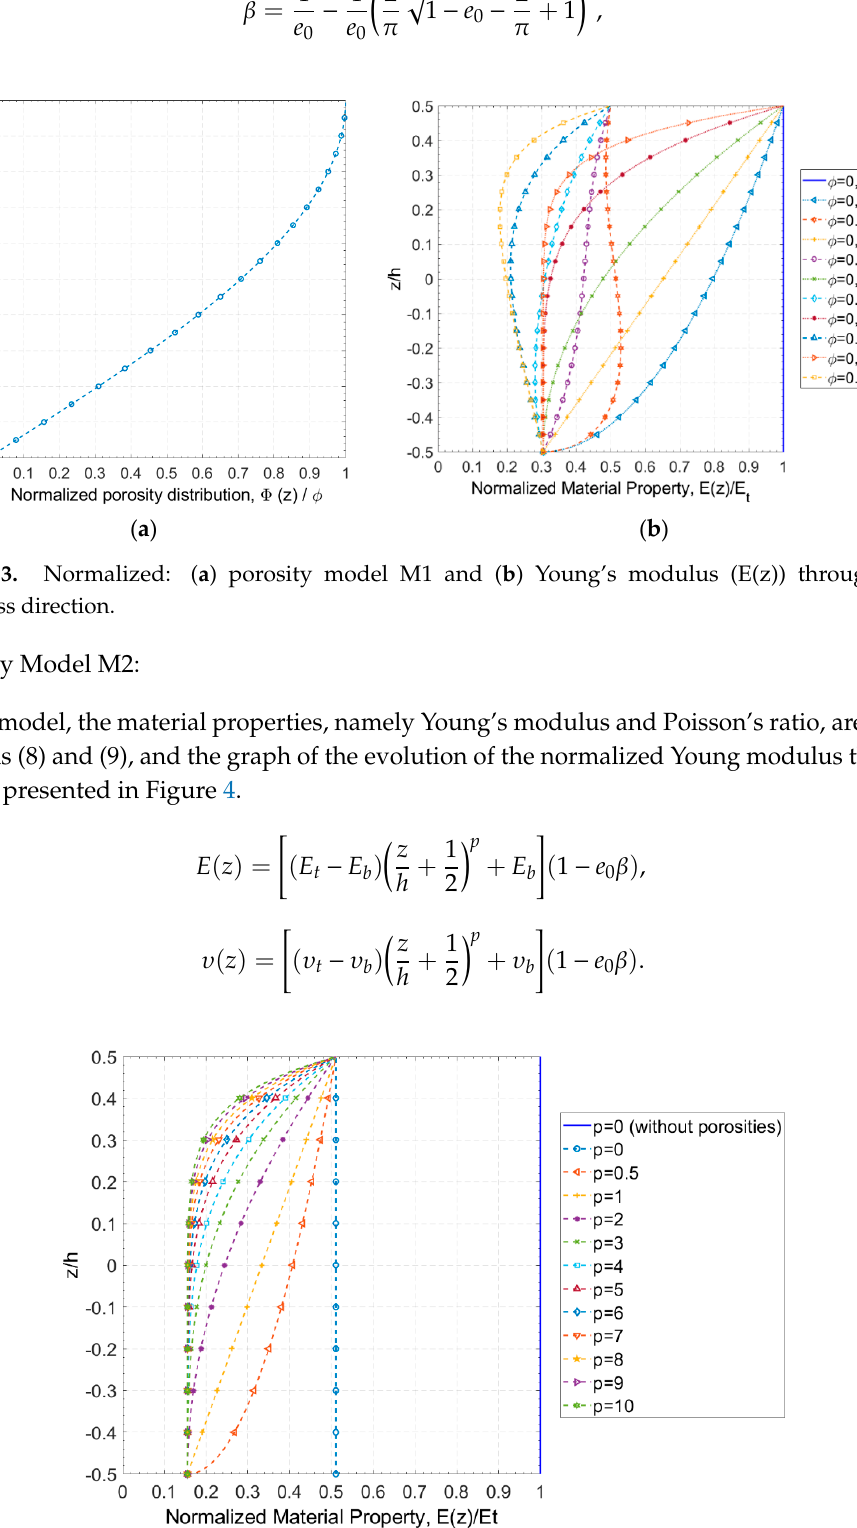
Figure 4. Variation of the normalized Young’s modulus (E(z)) through the thickness for porosity model